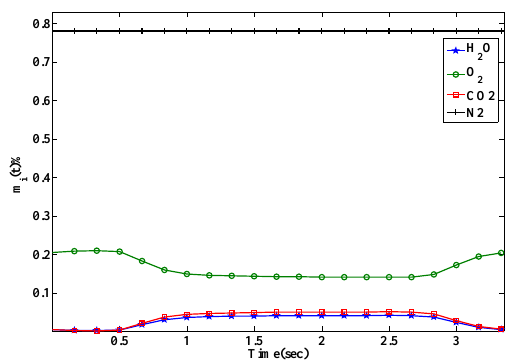
Figure 2: Alveoli gas composition during one respiration cycle.